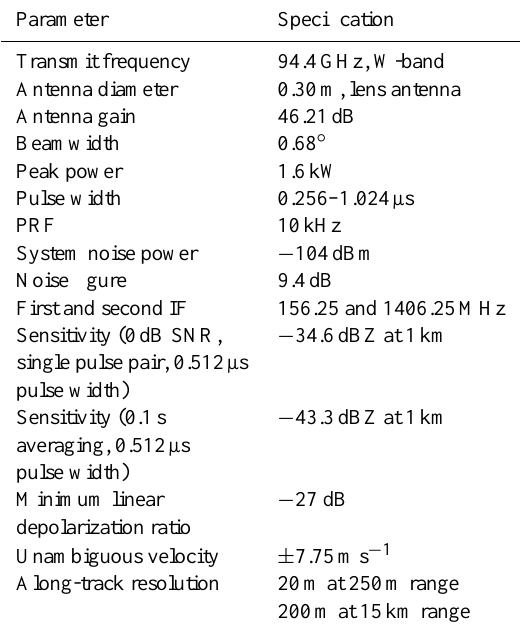
Table 1. HCR specifications.